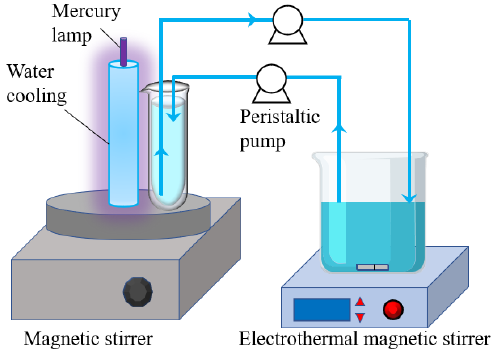
Figure 13. Schematic diagram of the experimental setup of a conventional photocatalytic reactor.